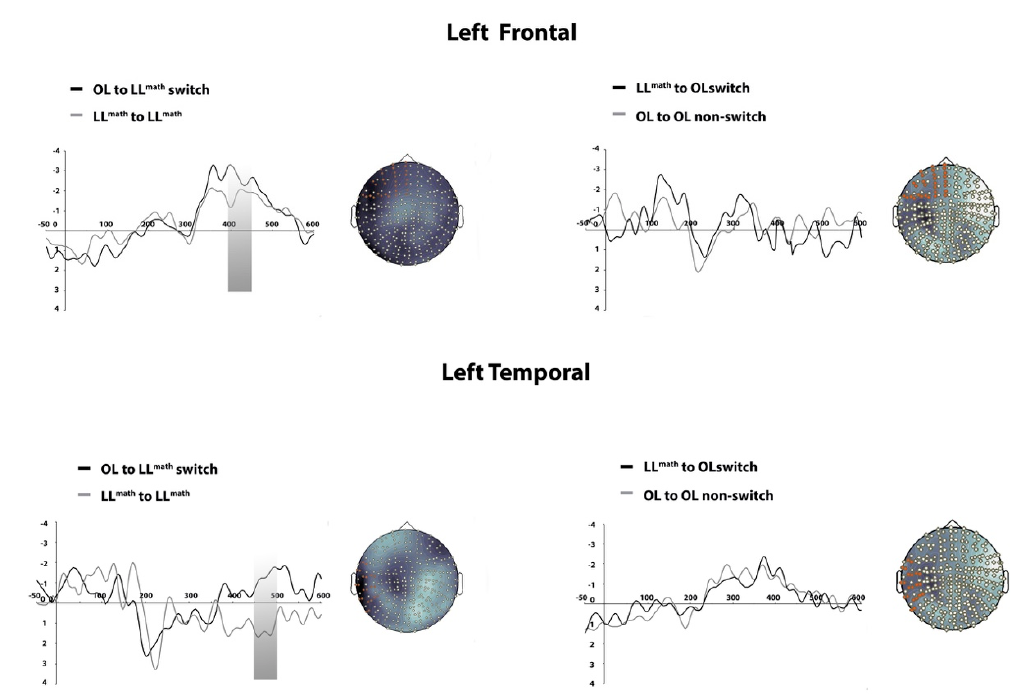
Figure 4. Event related fields (ERF) showing the asymmetry in the switch comparing the OL-LL math (left part of the figure) versus the LL math -OL switch (right part of the figure). The OL-LL math direction showed the asymmetry in the switch in two different time windows (400–450 ms and 450–500 ms). In the top of the image the switch effect was found in the left-frontal cluster in the 400–450 ms time window. In the bottom of the image the effect was found in the left temporal cluster for the 450–500 ms time window.